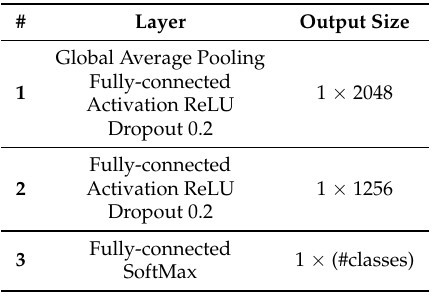
Figure 1. Architecture proposed for the inference stage. Once the CNNis trained, the neural codes (NC) from all the training samples are extracted. Then, given a query sample, its NC is extracted and subsequently compared using kNN to the k nearest prototypes from the training set using the Euclidean distance. Table 2. Description of the additional